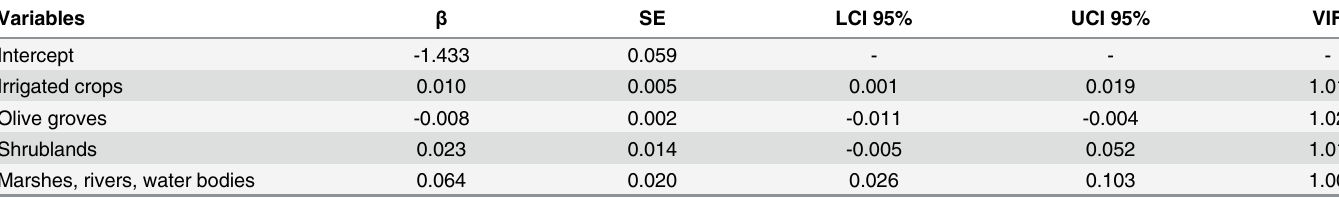
Marshes, rivers, water